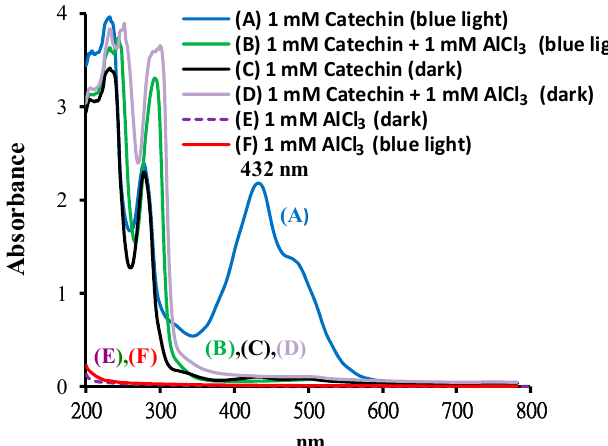
Figure 3. The absorption spectra of 1 mM catechin treated ( A ) without and ( B ) with 1 mM AlCl 3 under BLI at 20 W / m 2 for 120 min, and those of 1 mM catechin treated ( C ) without and ( D ) with 1 mM AlCl 3 in the dark. The absorption spectra of the solution containing 1 mM AlCl 3 treated ( E ) without or ( F ) with BLI at 20 W / m 2 for 120 min. The wavelengths for scanning reaction solutions were set in the region of 200–800 nm.